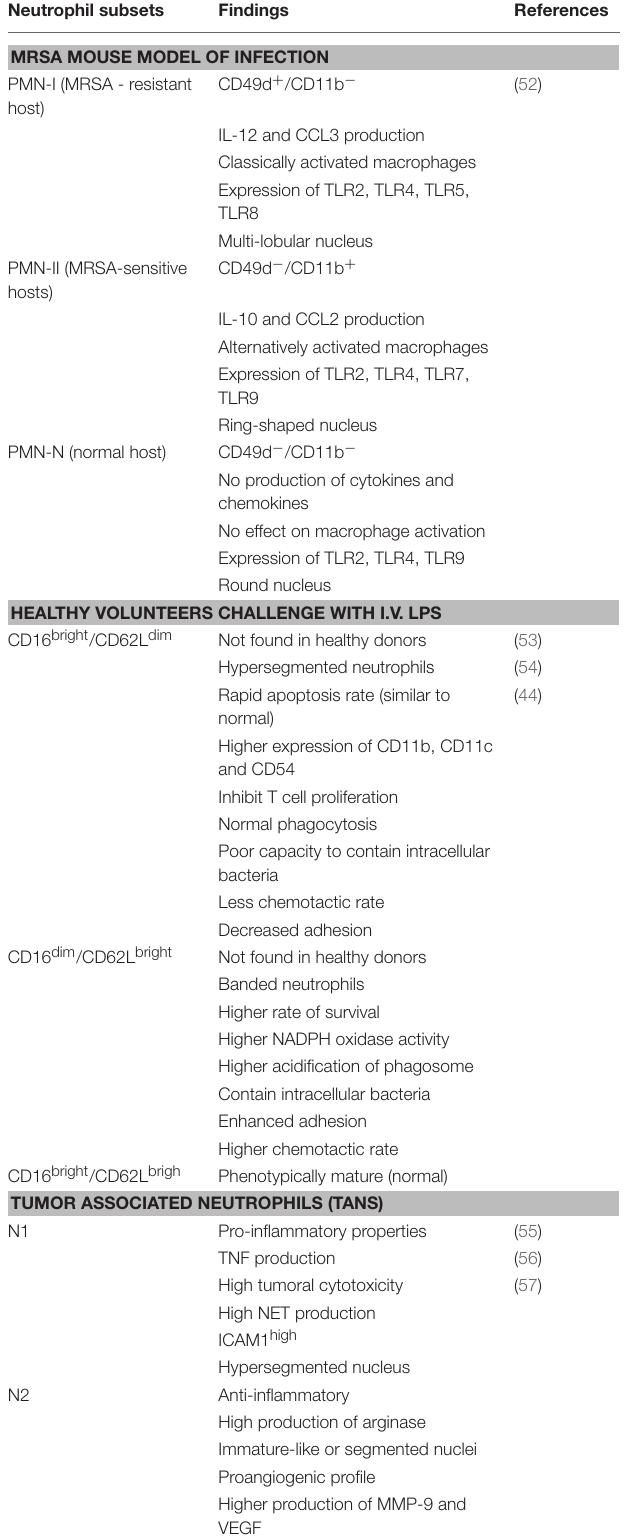
TABLE 1 | Studies of neutrophil